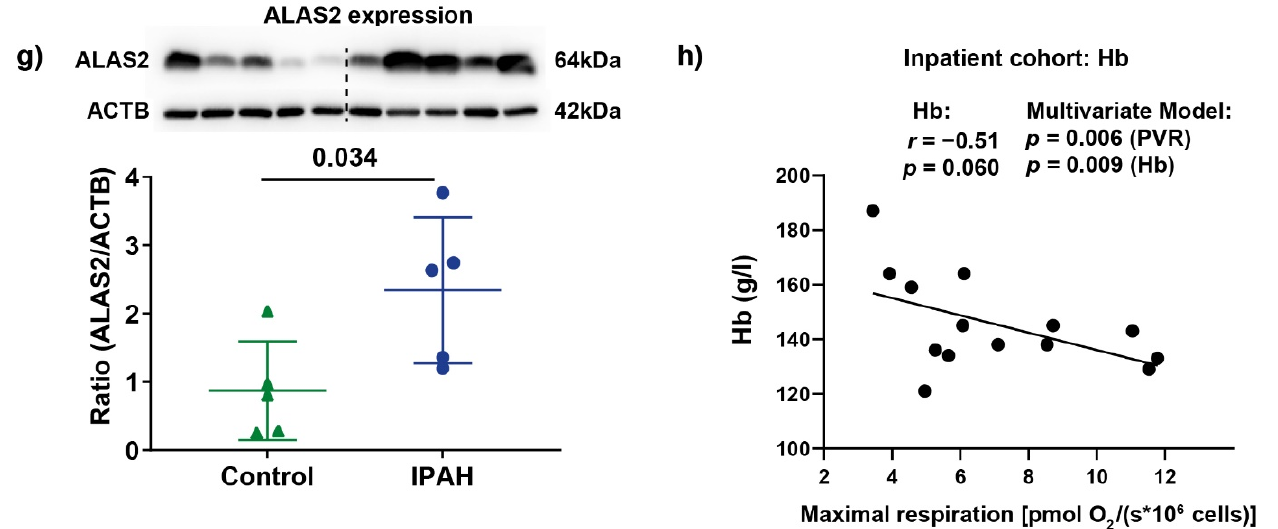
Figure 1. Mitochondrial respiration and its correlation with PAH. ( a ) Mitochondrial respiration in the intact, unstimulated PBMC of control patients ( n = 10), outpatients ( n = 15), and inpatients ( n = 14). Mitochondrial respiration was determined as oxygen consumption in unstimulated PBMC (“endogen”) after the inhibition of ATPase using oligomycin (representing proton leak respiration, “leak”) and after maximal stimulation via step-wise titration with the uncoupler FCCP (“maximal”). ( b ) Respiratory control ratios representing the phosphorylation control ratio (endogen/maximal: limitation of OXPHOS capacity by the phosphorylation system), relative OXPHOS capacity (endogen- leak/maximal), and the coupling control ratio (oligo/maximal: index for uncoupling). Data are shown as the median and interquartile range. ( c , d ) The correlation between endogen and the maximal respiration of PBMC from the inpatient cohort with PVR: ( c ) the CI; ( d ) determined using linear regression analysis ( p - and r -values). Multivariate analysis for the adjustment of maximal respiration for age and gender (p* -values). ( e , f ) Microarray analysis comparing the gene expression of the PBMC of control patients ( n = 7) with that of HPAH (n = 3) and IPAH ( n = 4) patients. The volcano plots show mitochondria-related genes: ( e ) genes related to heme synthesis and iron metabolism; ( f ) COX15: Cytochrome c oxidase assembly protein COX15 homolog, also known as heme A synthase, NFS1: cysteine desulfurase, ALAS2: 5-aminolevulinate synthase 2, CPT1: carnitine-palmitoyl-transferase 1, FTMT: mitochondrial ferritin, HB: hemoglobin. ( g ) The protein expression of ALAS2; data are shown as mean ± SD, p = 0.034, analyzed using a t -test. ( h ) The correlation between the maximal respiration of the PBMC of the inpatient group and Hb determined using linear regression analysis. Multiple linear regression with maximal respiration as the dependent variable and age, gender, PVR, and Hb as the independent